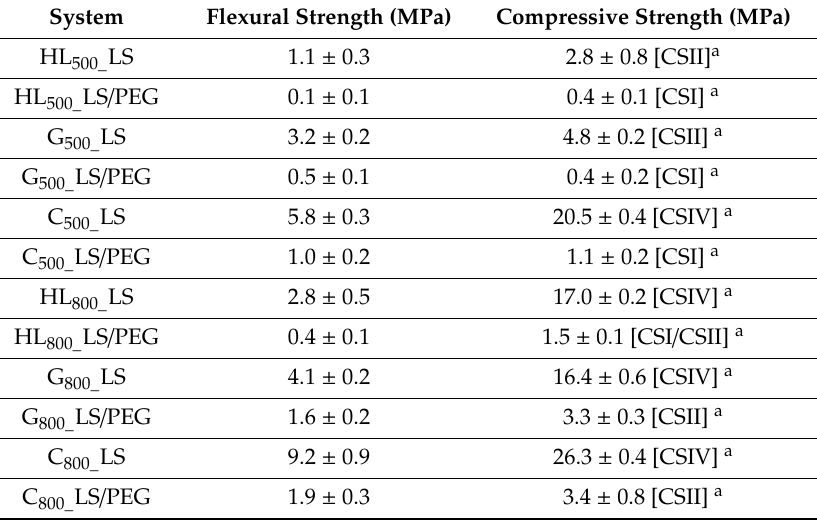
Table 4. Mechanical properties of the cured mortars measured in flexural and compressive